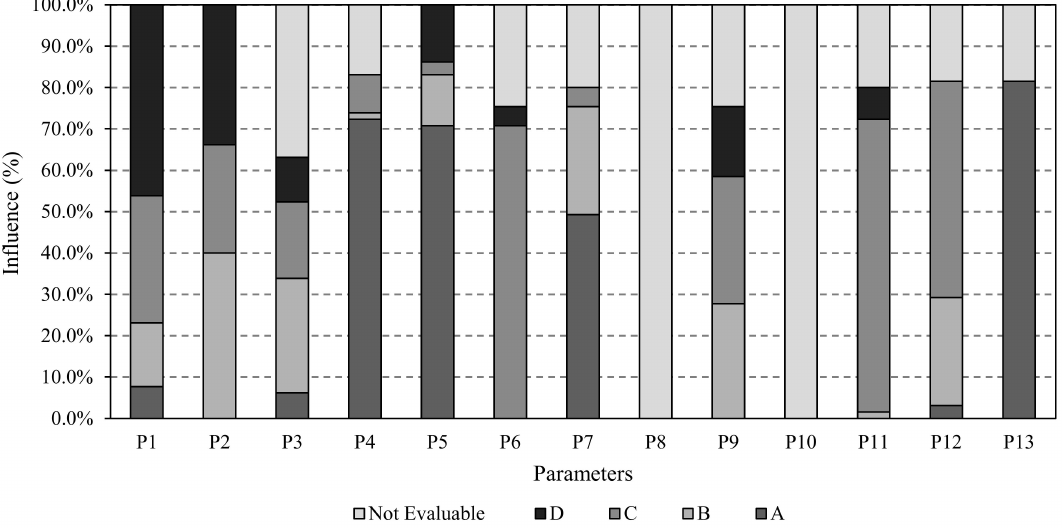
Figure 13. Vulnerability class distribution for each parameter, considering the façade